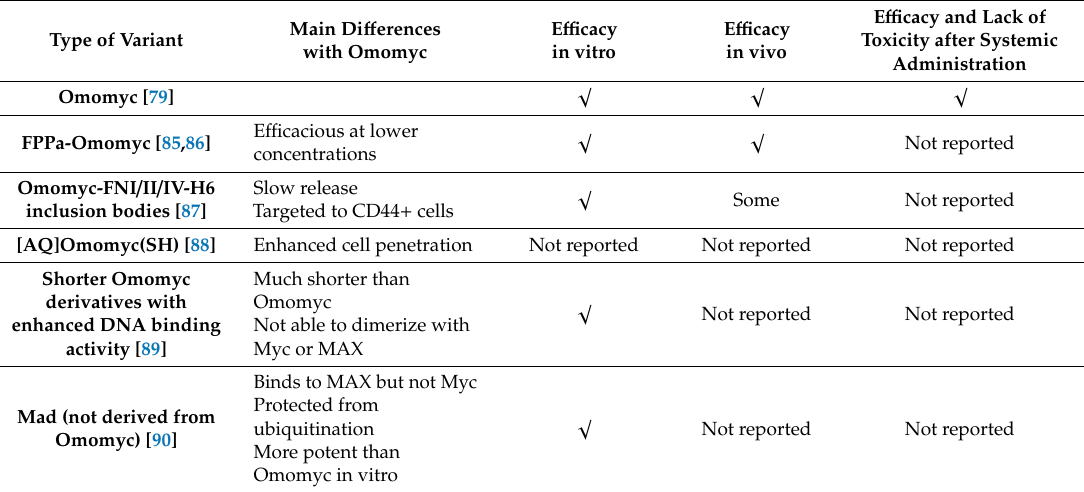
Table 1. List of Omomyc variants and their